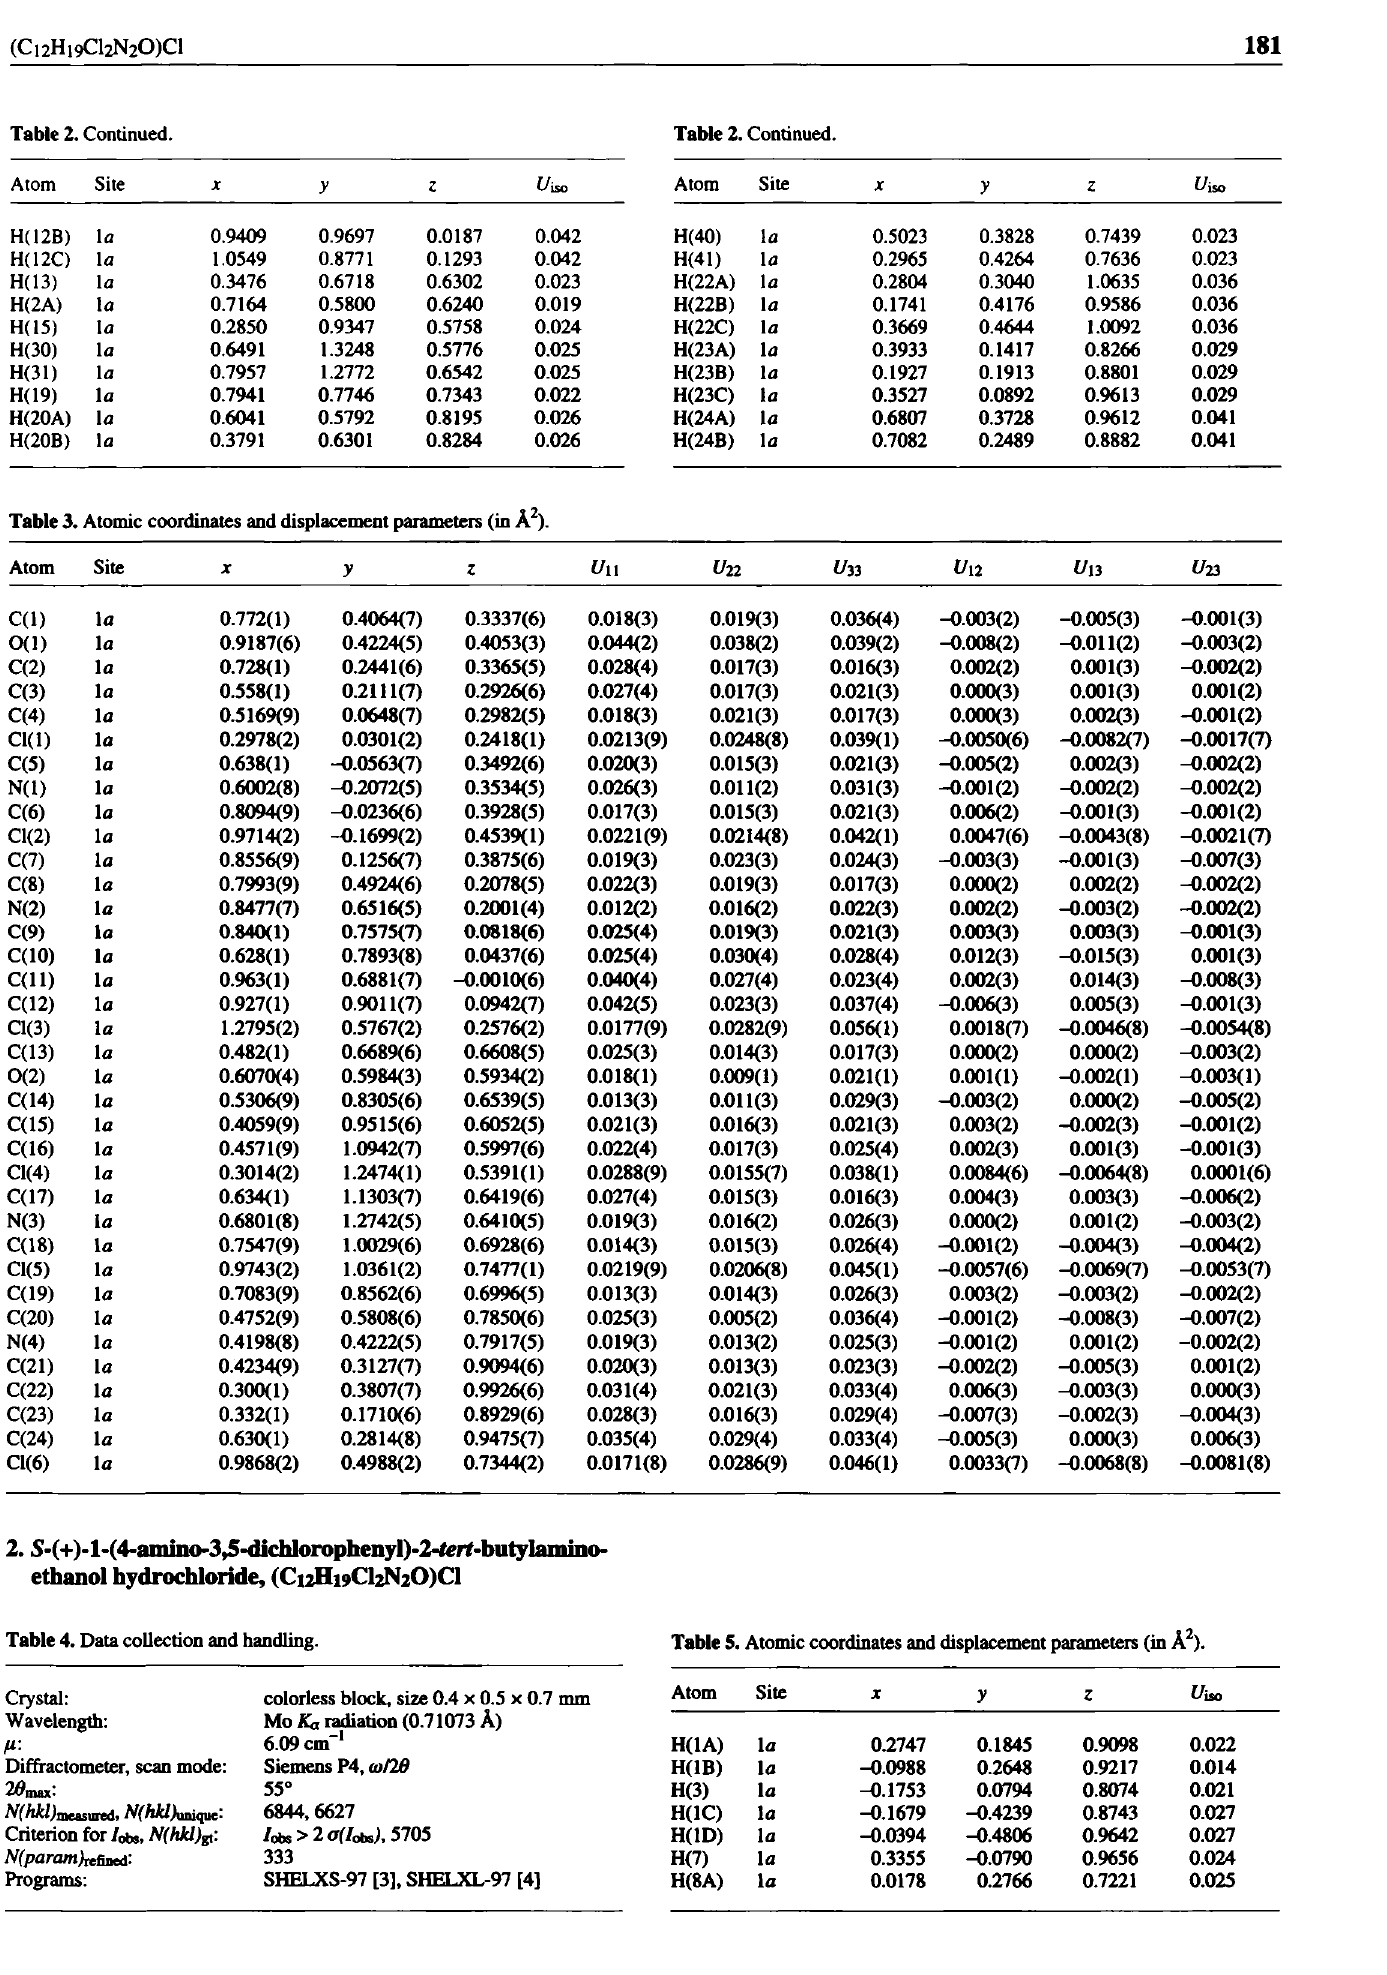
Table 3. Atomic coordinates and displacement parameters (in A 2 ).